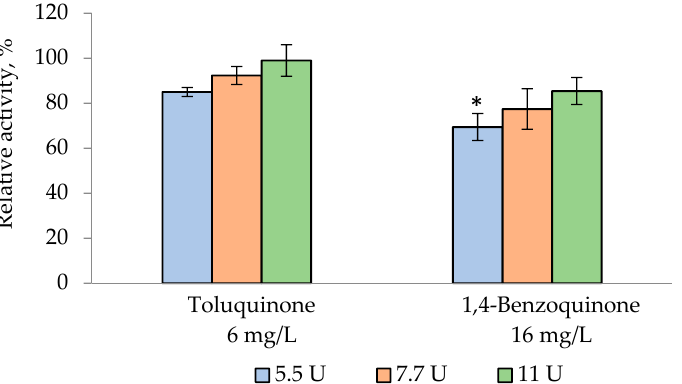
Figure 4. Dependence of the relative activity of trypsin in the presence of quinones on the amount of the enzyme. A decrease in the amount of trypsin in the reaction mixture led to an insubstantial increase in the sensitivity of the trypsin-assay system to benzoquinone and toluquinone. * Values of p < 0.05 when comparing the relative activity values obtained in the presence of 11 U of trypsin. The highest tested concentration of the food preservative sodium benzoate, 144 mg/L, did not a ff ect the trypsin activity. At the same time, another food preservative—potassium